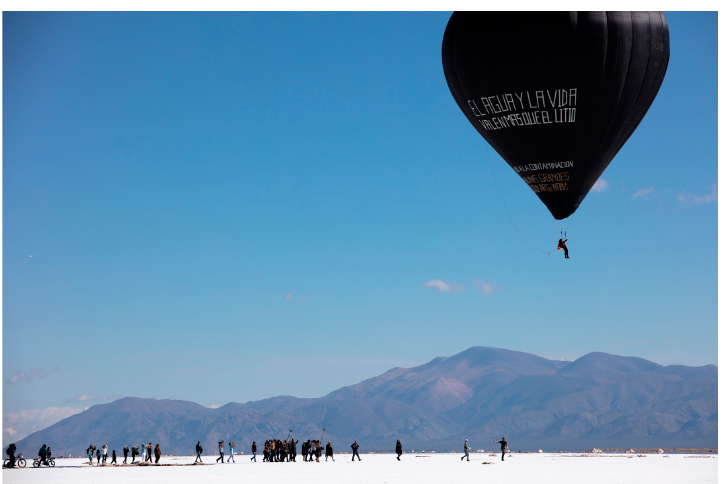
Figure 5. Tomás Saraceno, Aerocene (Fly with Aerocene Pacha). 21–28 January 2020, Salinas